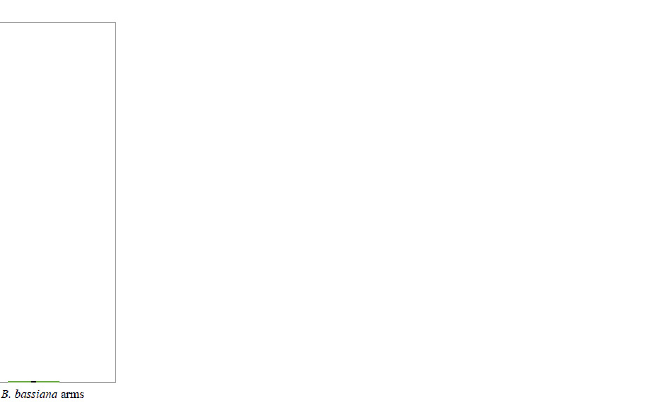
Table 1. Volatile organic compounds (VOCs) detected from sample of Tenax (Control). Peak No.